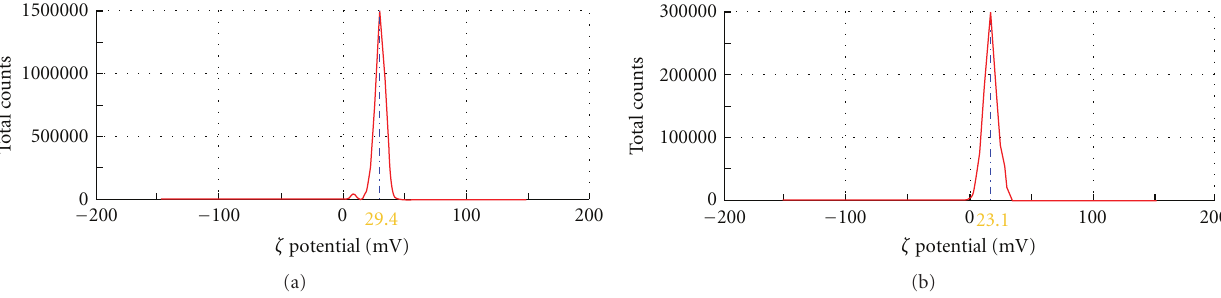
Figure 2: Zeta potential assay of nanoparticles and nanoparticle/DNA complexes. (a) The value at the peak of the curve shows that the Zeta potential of the nanoparticles is +29.4 mV. (b) The Zeta potential of the nanoparticle/DNA complexes drops down to +23.1 mV compared with nanoparticles alone.